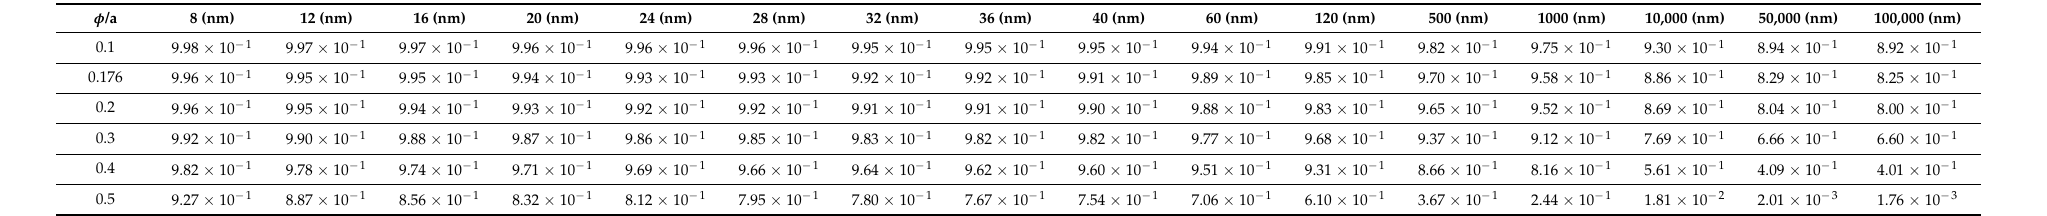
Table 3. DLVO total potential energies between coarse (80 µ m) and fine/ultra-fine particles at different solid fractions and particle sizes for the same quartz particles with different particle